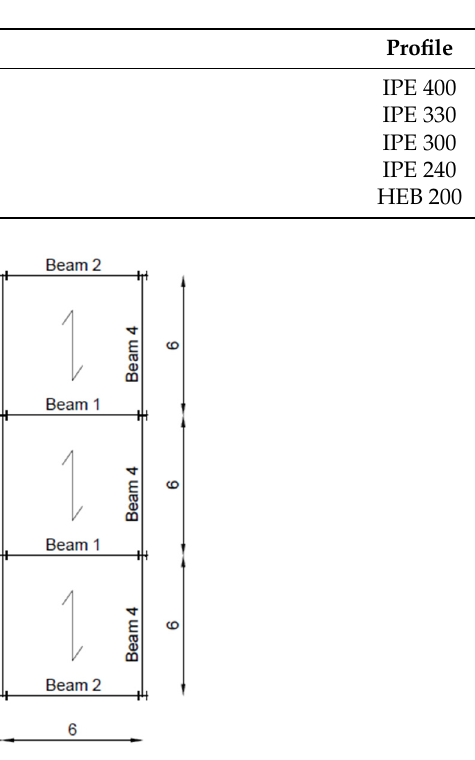
Table 3. Beam and column cross-sections of all of the one-floor case studies (from 1 to 4) after vertical static analysis design.